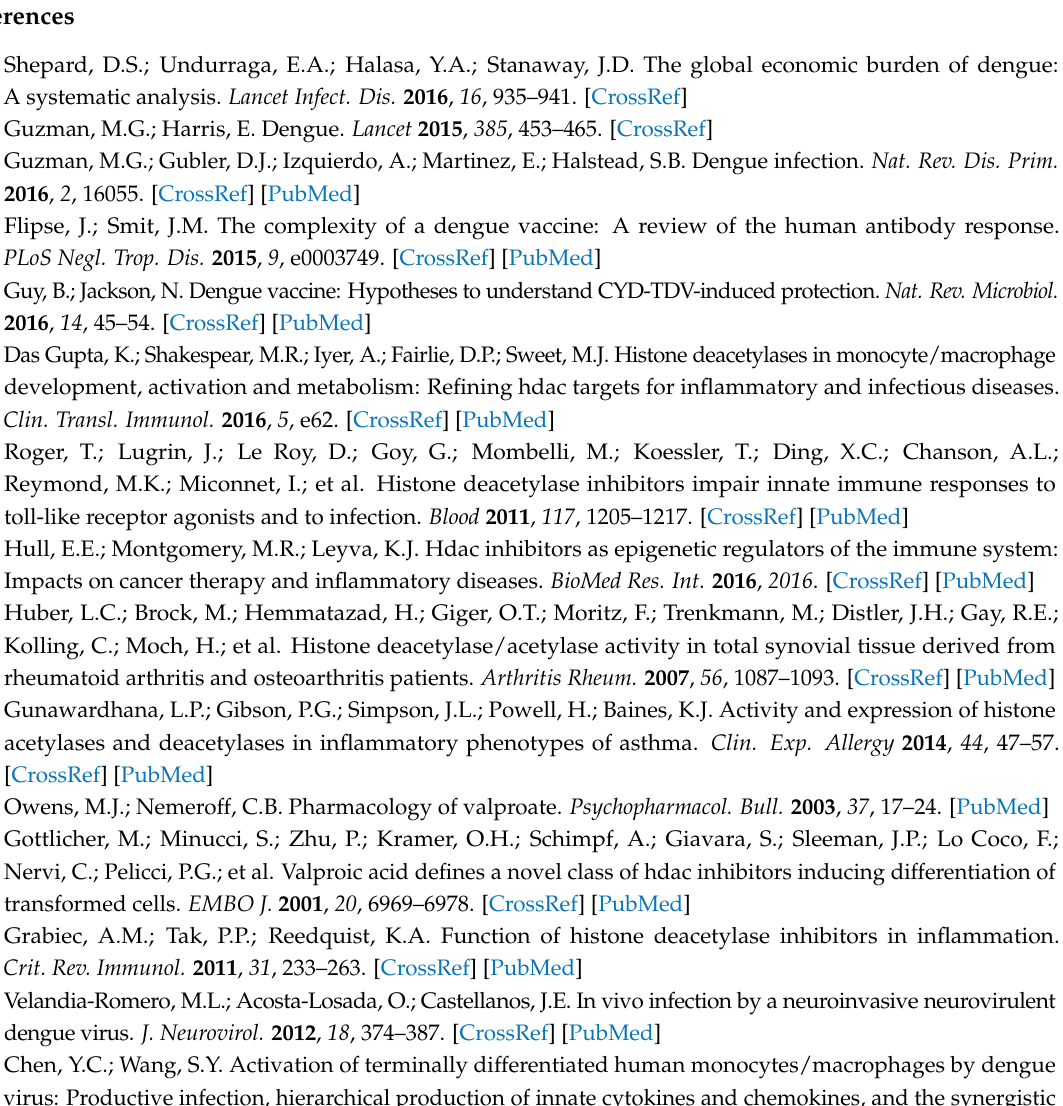
Figure S1: Morphological development of human monocyte-derived macrophages